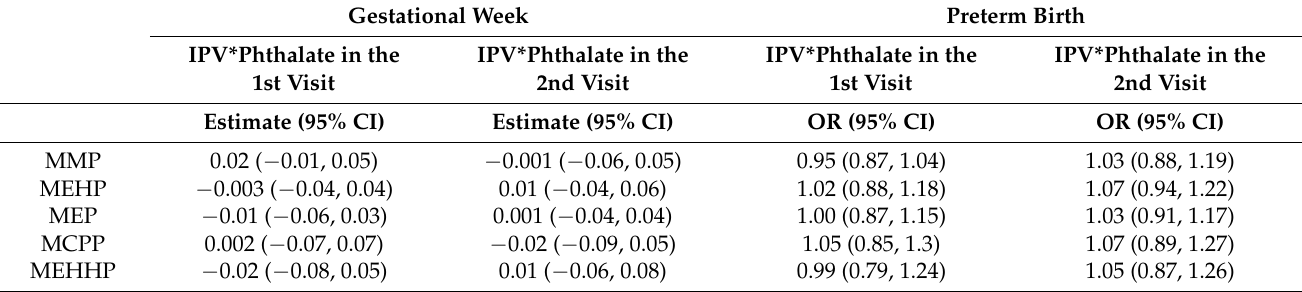
Table A3. Estimated effects of the interaction between Intimate partner violence and individual phthalates in each